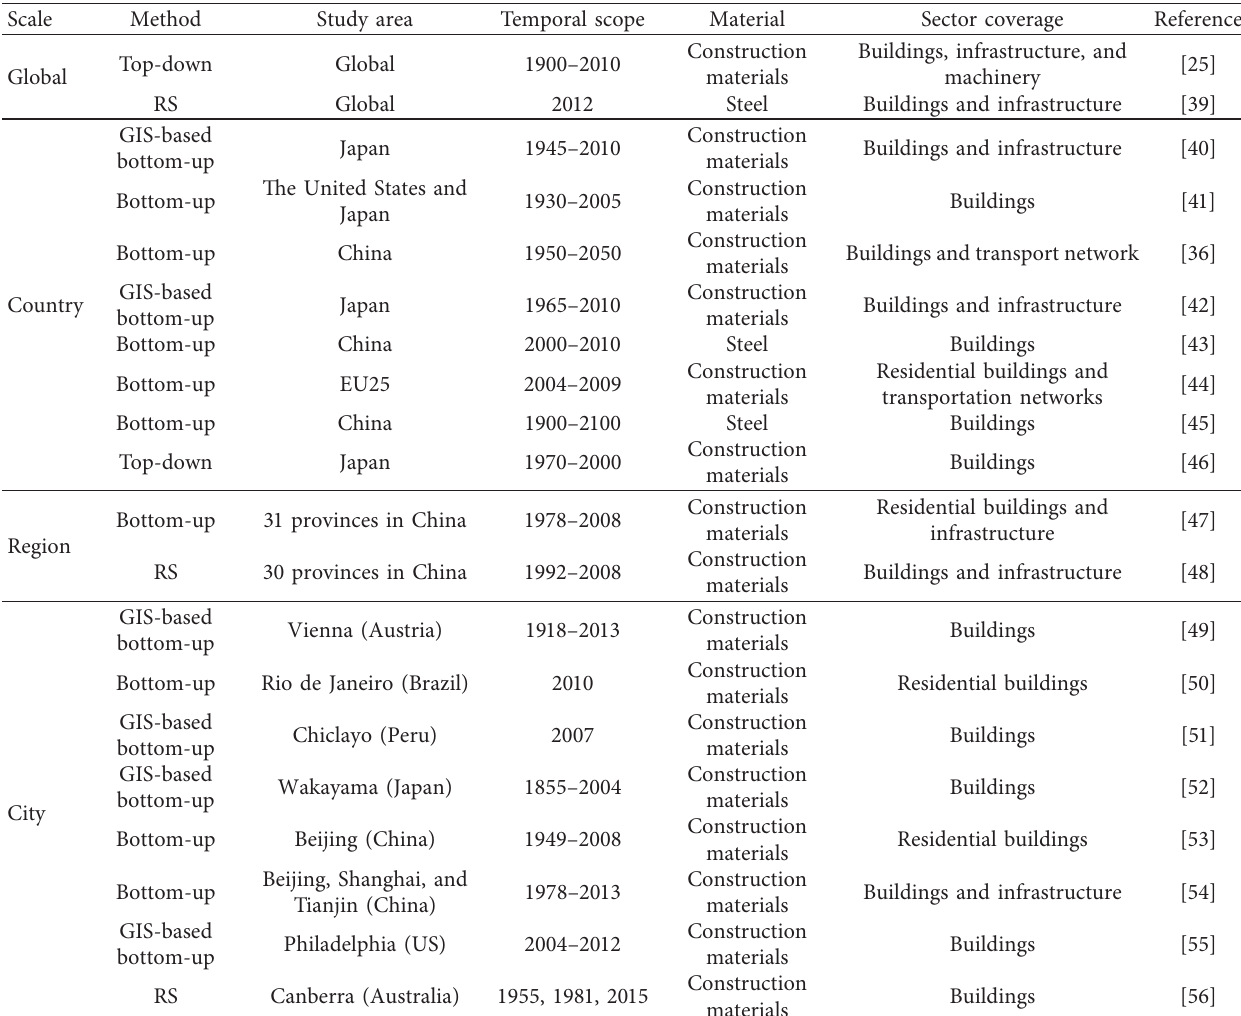
Table 1: Studies on the material flow of infrastructure. Top-down � top-down account method. Bottom-up � bottom-up account method. RS � remote sensing. GIS � geographical information